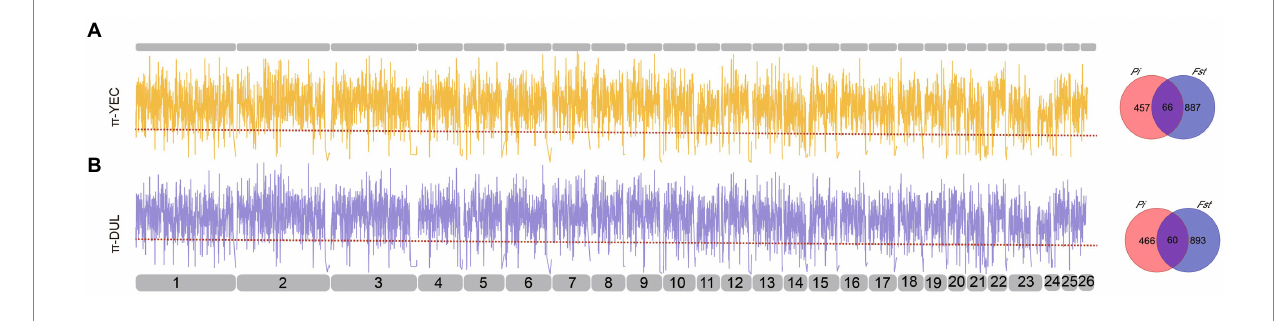
FIGURE 5 Pi analysis results of YEC and DUL. The intersection with Fst results obtained 66 (A) and 60 (B) genes, respectively.